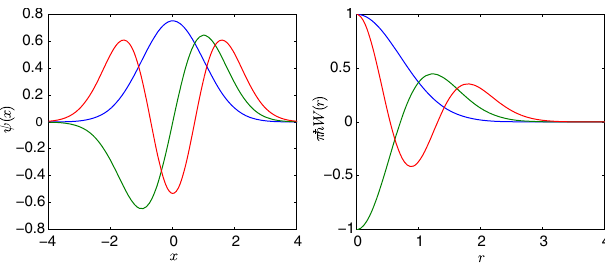
FIG. 4. First three states (left) of a simple harmonic oscillator along with the radial Wigner distribution